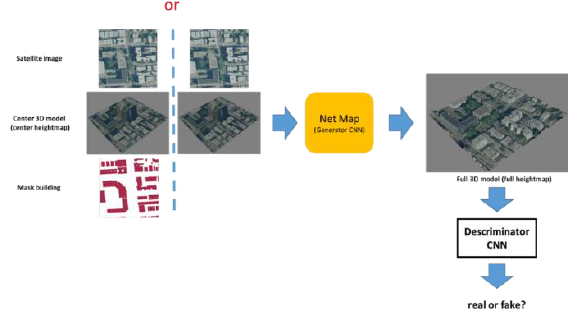
Figure 3. 3D reconstruction as GAN problem.